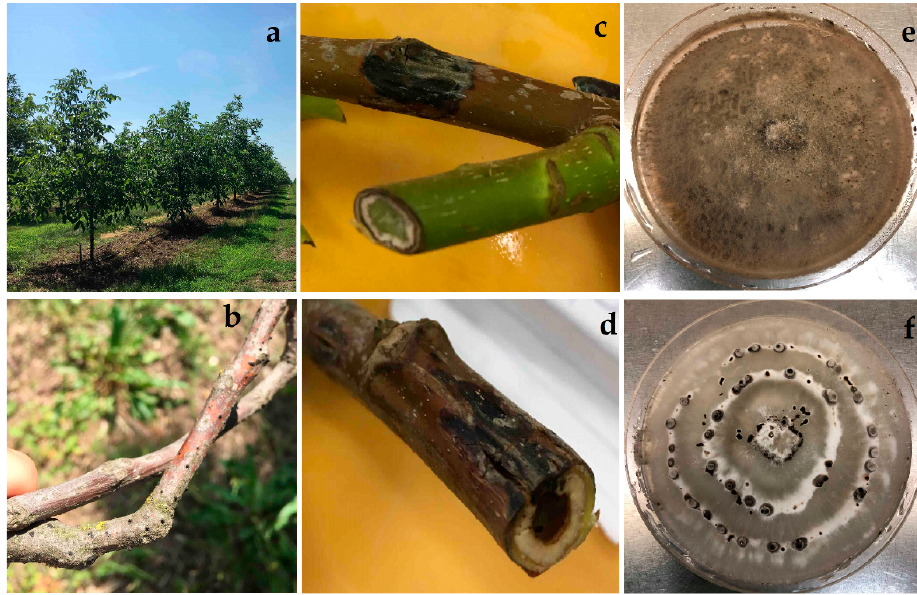
Figure 4. ( a ) Walnut orchard in Hajdúdorog. ( b ) Walnut twig with black pycnidia. ( c ) External lesions. ( d ) Internal lesions. ( e ) Diplodia seriata on the PDA medium. ( f ) Diaporthe eres on the PDA medium.